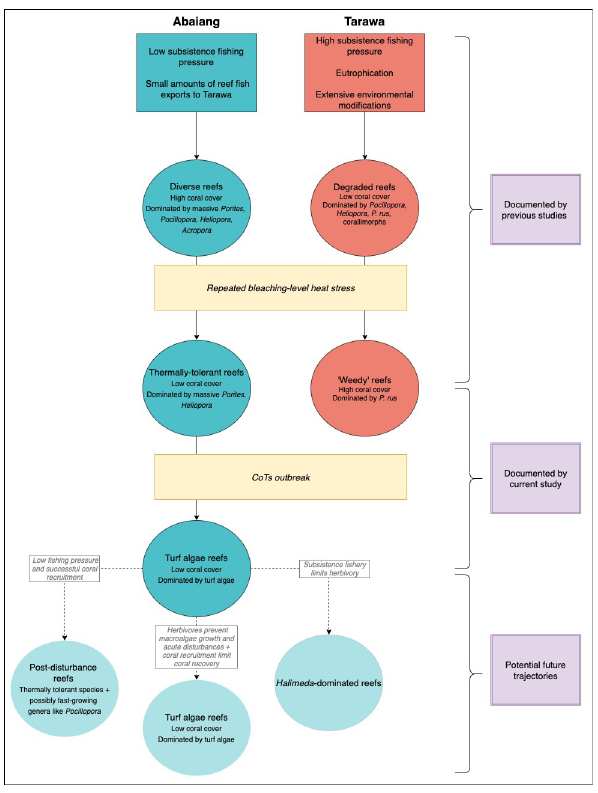
Fig 5. Proposed drivers of community composition on reefs in Tarawa and